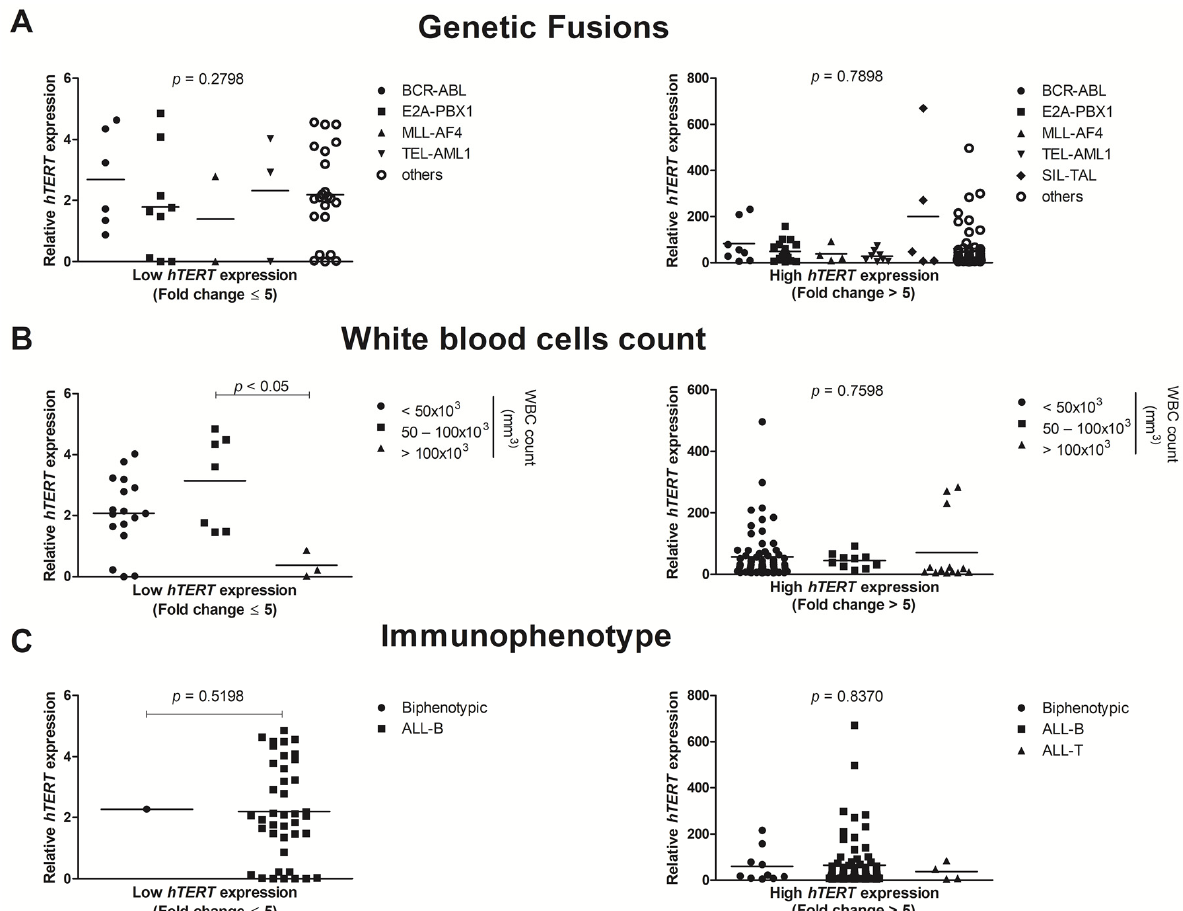
Figure 2. The ALL pediatric cohort ( n = 148) was separated into two groups, with low (fold change ≤ 5) and high (fold change > 5) hTERT expression. ( A ) Those patients did not statisticaly differ despite all genetic fusions. ( B ) For WBC, only in the group with low hTERT expression, a significant difference was observed between 50–100 × 10 3 mm 3 and >100 × 10 3 mm 3 samples ( p < 0.05) ( C ) Immunophenotype features did also not present significant results in low or high hTERT expression groups. Relative hTERT expression was calculated using ABL and GAPDH as endogenous normalizers. Data are presented as the median and each dot plot represents the hTERT expression in a single patient. For statistical analysis, the Shapiro–Wilk normality test was performed, followed by the Kruskal–Wallis test and Dunn’s Multiple Comparison post-test. WBC: white blood cells count, ALL: acute lymphoblastic